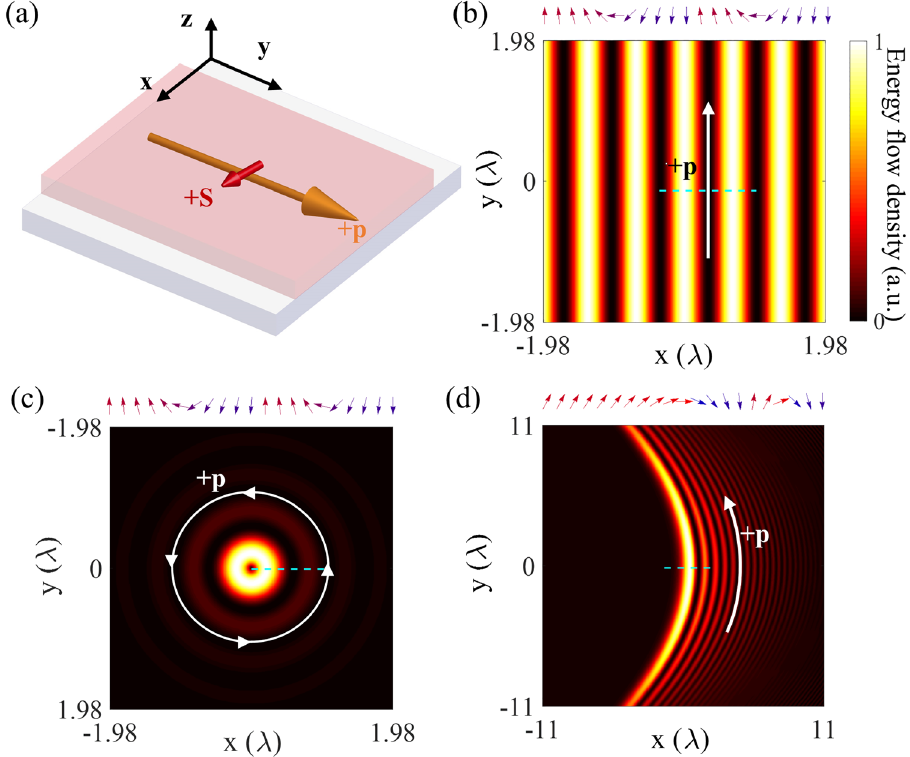
Figure 5: Transverse spins and spin – momentum locking in various evanescent SPP waves arising from the spatial variation of the kinetic momentum/Poyntingvector:(a)inanunstructuredevanescentplanewave,anin-planetransversespinispresentbecausethePoyntingvector normal to the interface decays [67]; (b – d) in structured evanescent waves such as (b) the cosine wave, (c) the Bessel wave, and (d) the Airy wave,thereexistsbesidesthein-planetransverseSAMasin(a),anothertypeoftransversespinalignednormaltotheinterfacethatisinduced by the in-plane Poynting vector arising from the variation in energy fl ow density within the interface. The spin vectors of the structured beams swirl around the energy fl ow lobes and their local orientations vary from the ‘ up ’ to the ‘ down ’ states, obeying the right-hand rule (see inserts above the panels; the vector graphs show the normalized spin vector along the green lines in the corresponding fi gures). These orientations are inverted for waves with an opposite direction to the energy fl ow. Note that for beams with curved trajectories, the spin variation is considered in the plane perpendicular to the local tangential direction of the energy fl ow